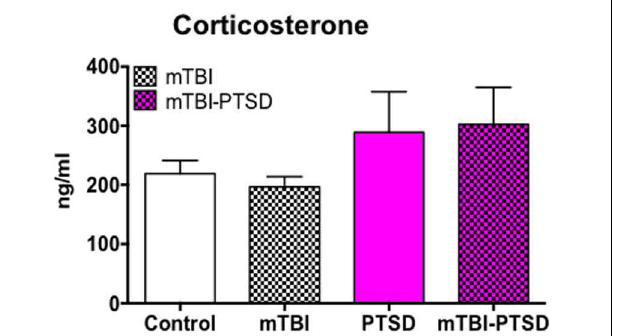
FIGURE 5 | Neuroendocrine response to mTBI and PTSD. Plasma baseline levels of corticosterone showed a trend toward increase in PTSD and mTBI-PTSD only animals ( > + 70ng/ml) compared to control. This trend did not reach statistical significance after analyses with Krukal Wallis-One Way ANOVA followed by Dunn’s correction for multiple testing. mTBI animals showed a similar baseline level of corticosterone as controls. Data are presented as mean ± SEM. ( N =